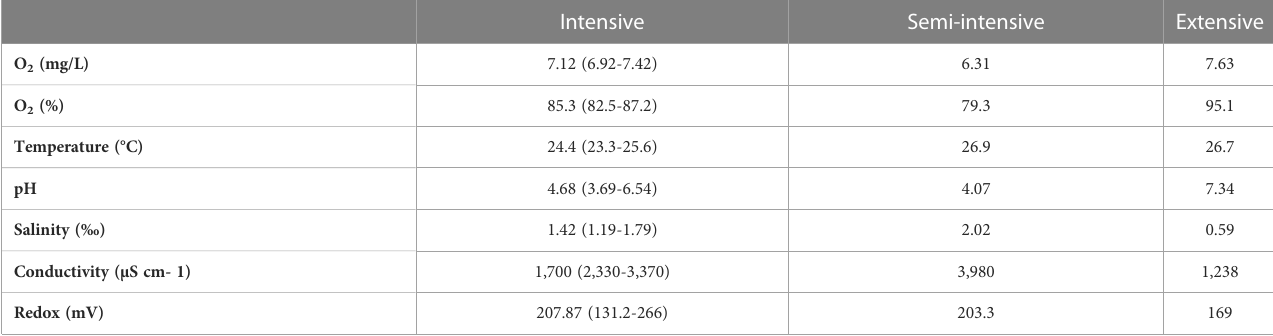
TABLE 1 Mean values of physicochemical water parameters measured from each system (intensive, semi-intensive and extensive) at each sampling date. Intensive Semi-intensive Extensive O 2